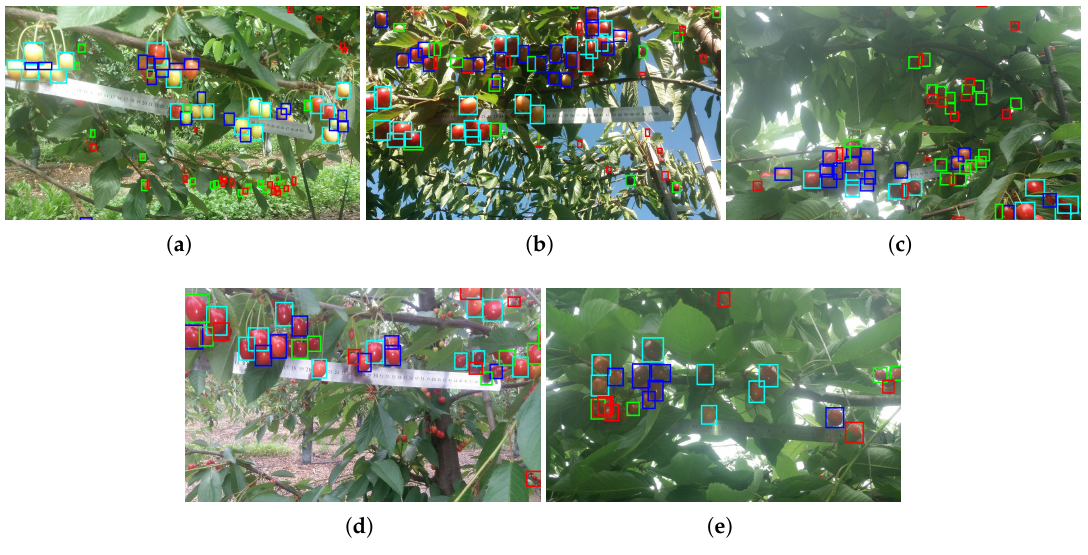
Figure 8. Several snap-shots of the cherries detection and classification processes. As can be seen ( a – e ), there exists misclassification or cherries missing in the recognition